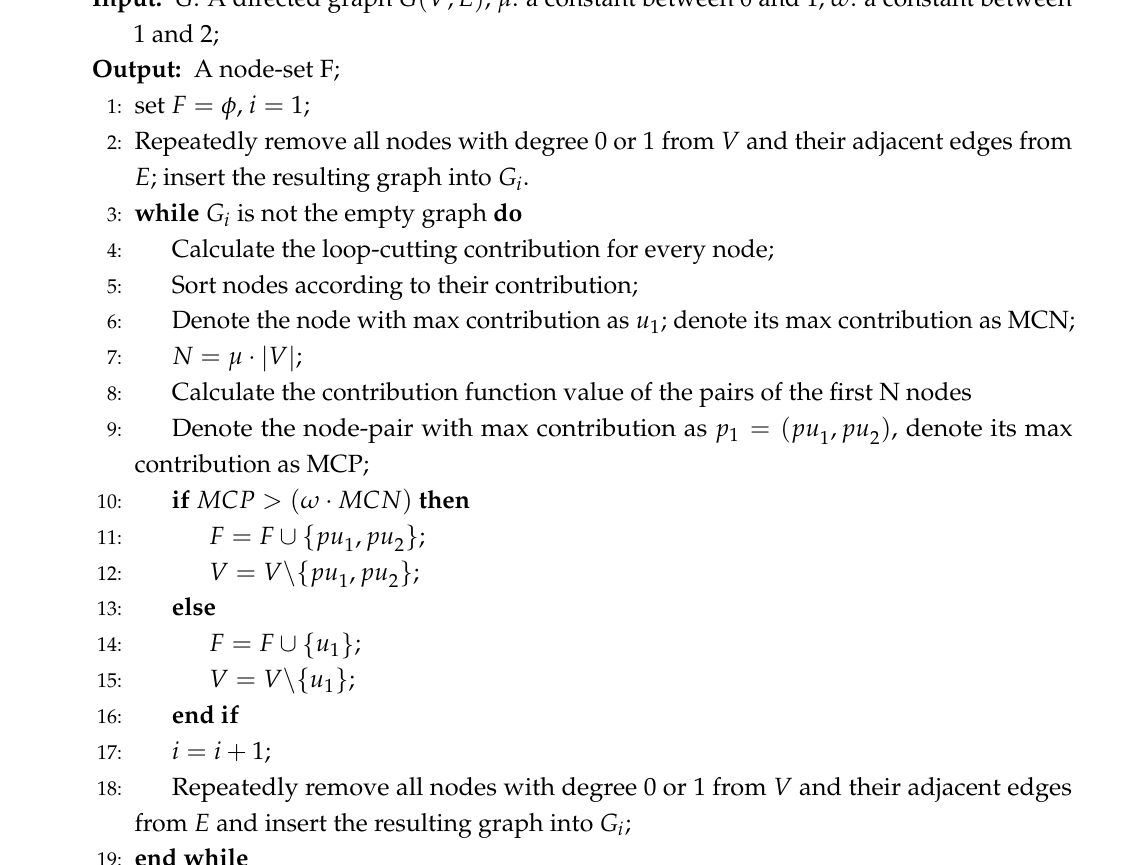
Figure 4 applies the CFA algorithm to the Bayesian network model given in Figure